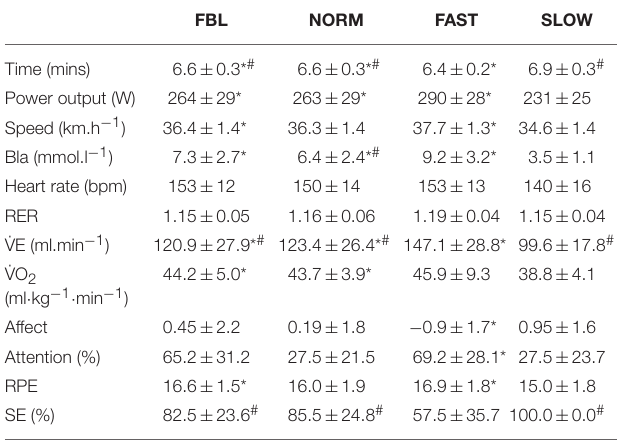
TABLE 2 | Mean ± SD values for the initial quartile during each starting strategy